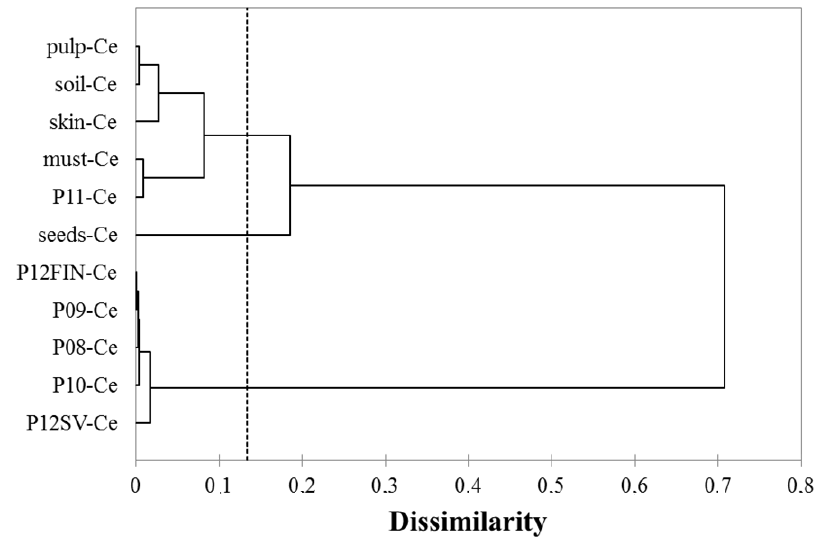
Figure 6. Dendrogram obtained with agglomerative hierarchical clustering (AHC) on Ce-normalized